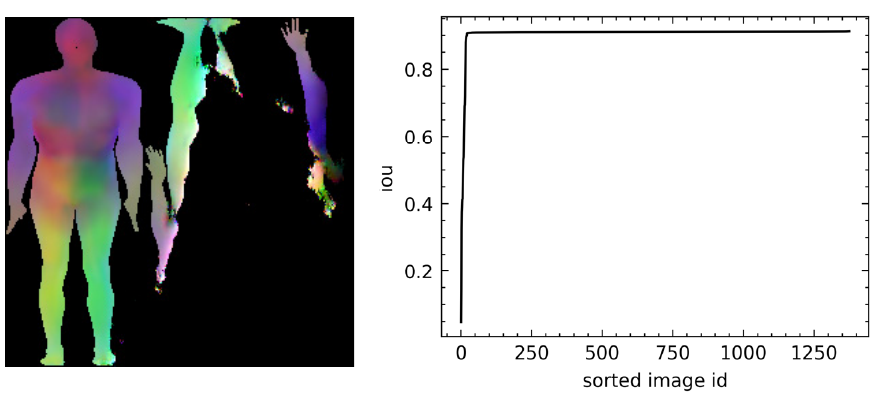
Figure 6. Example of full-body scans. The three columns on the left are sampled using our approach, and the three columns on the right are samples generated using the PCA-based approach. Subjectively, our approach provides realistic scans more often than the PCA-based approach, where we observe extreme shape features and often bodies with mixed gender that are not representative of the input dataset.